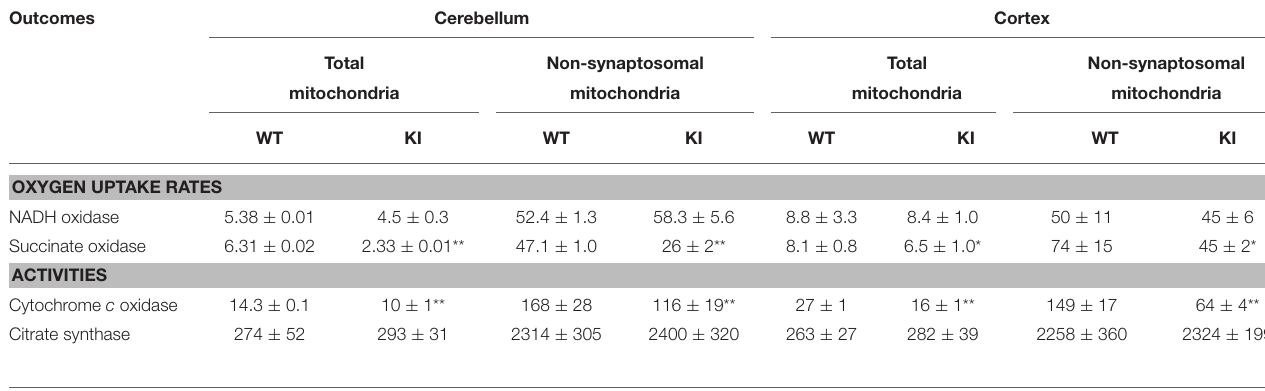
TABLE 1 | Comparison of outcomes in mitochondria-enriched fractions vs. purified, non-synaptosomal mitochondria from cerebellum and cortex at PND21 in WT and KI mice. Outcomes